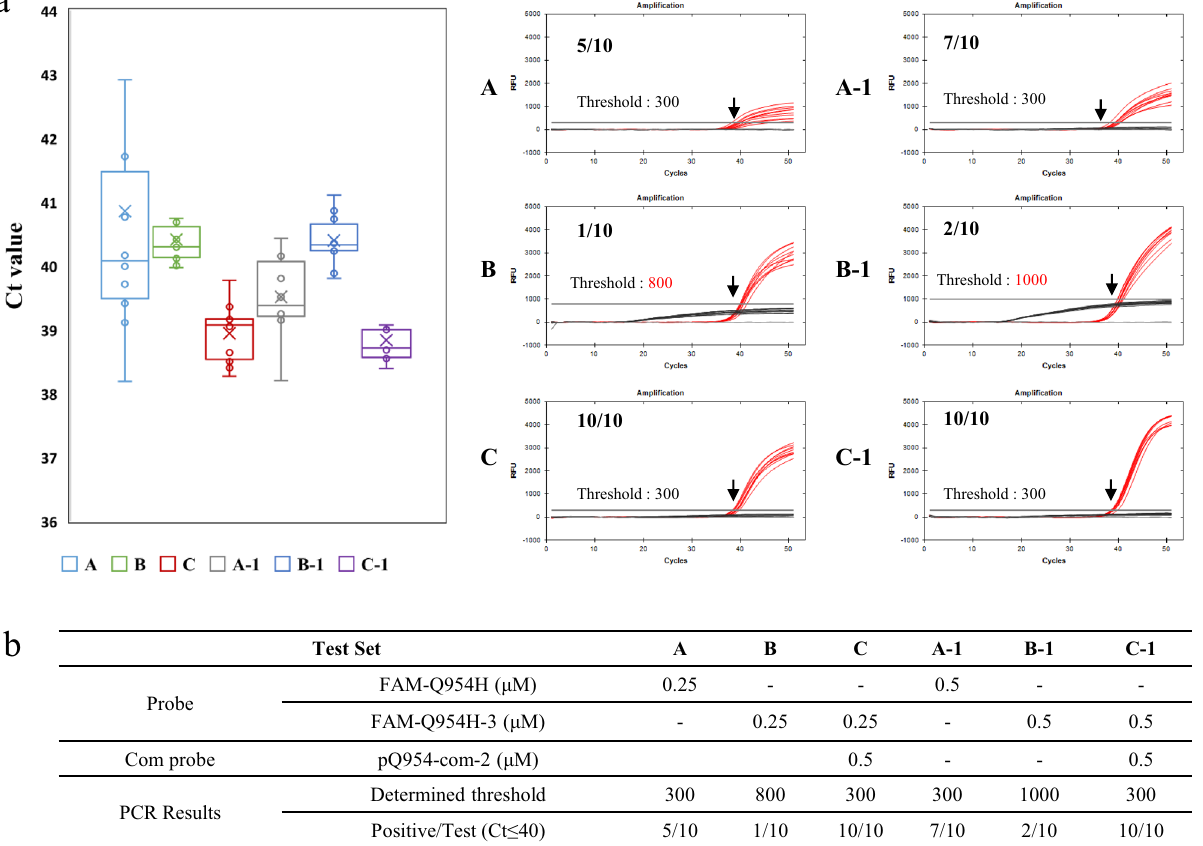
Figure 4. STexS II validation of the Com probe as a viable method for effective positive detection. Validation of signal enhancements and nonspecific signal diminish by Com probes. ( a ) PCR and Ct value of Omicron